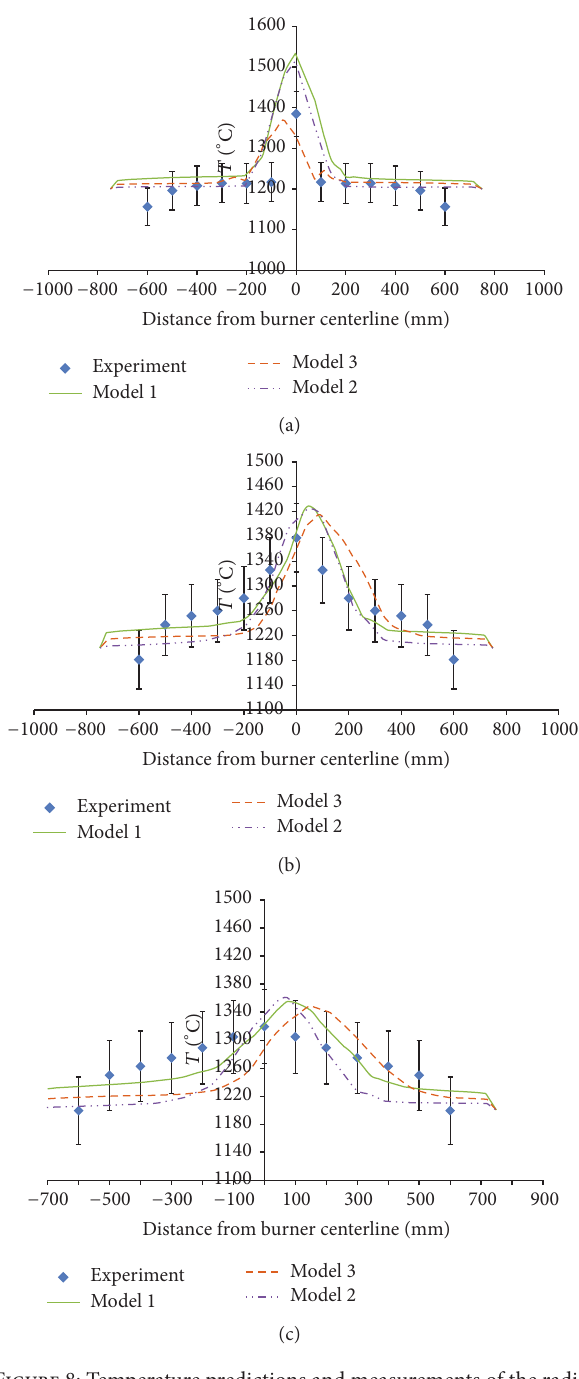
Figure 8: Temperature predictions and measurements of the radial axis at the positions (a) 𝑥 = 359 mm, (b) 𝑥 = 1116 mm, and (c) 𝑥 = 1862